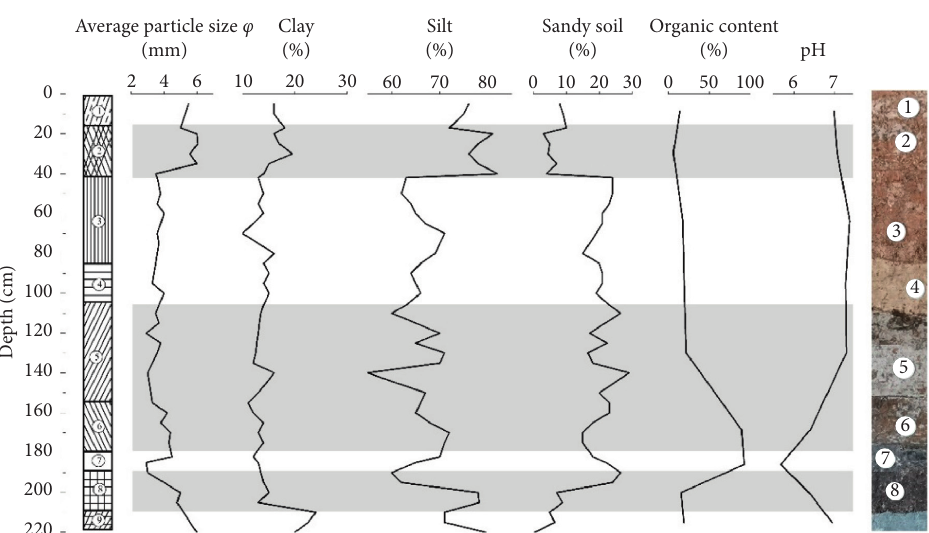
Figure 2: Curves of composition of particulate, organic content, and pH of 9 layers in the Tianluoshan